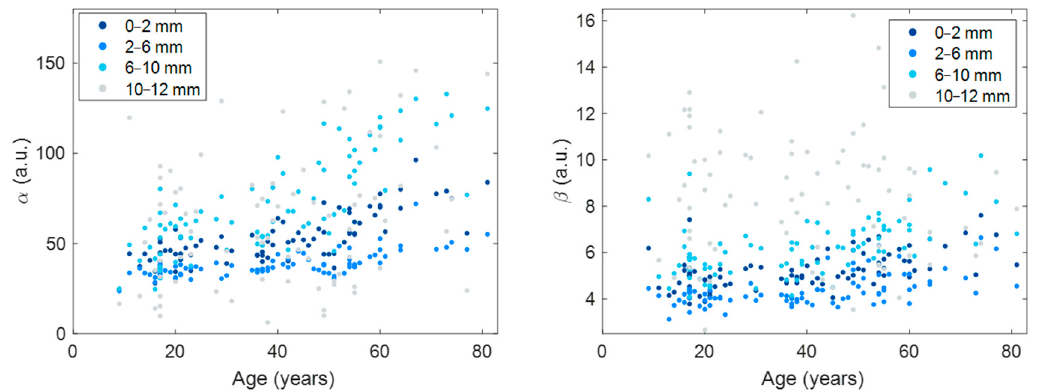
Figure 3. Scatter plots of α ( left ) and β ( right ) against age for different corneal areas of analysis. α and β are expressed in arbitrary units (a.u.). Corresponding statistics are shown in Table 4. Table 4. The Pearson correlation coe ffi cient and the corresponding p -value of the α and β with age, depending on the corneal area considered. The overall cornea is also considered. Corresponding sca tt er plots are shown in Figure 3.